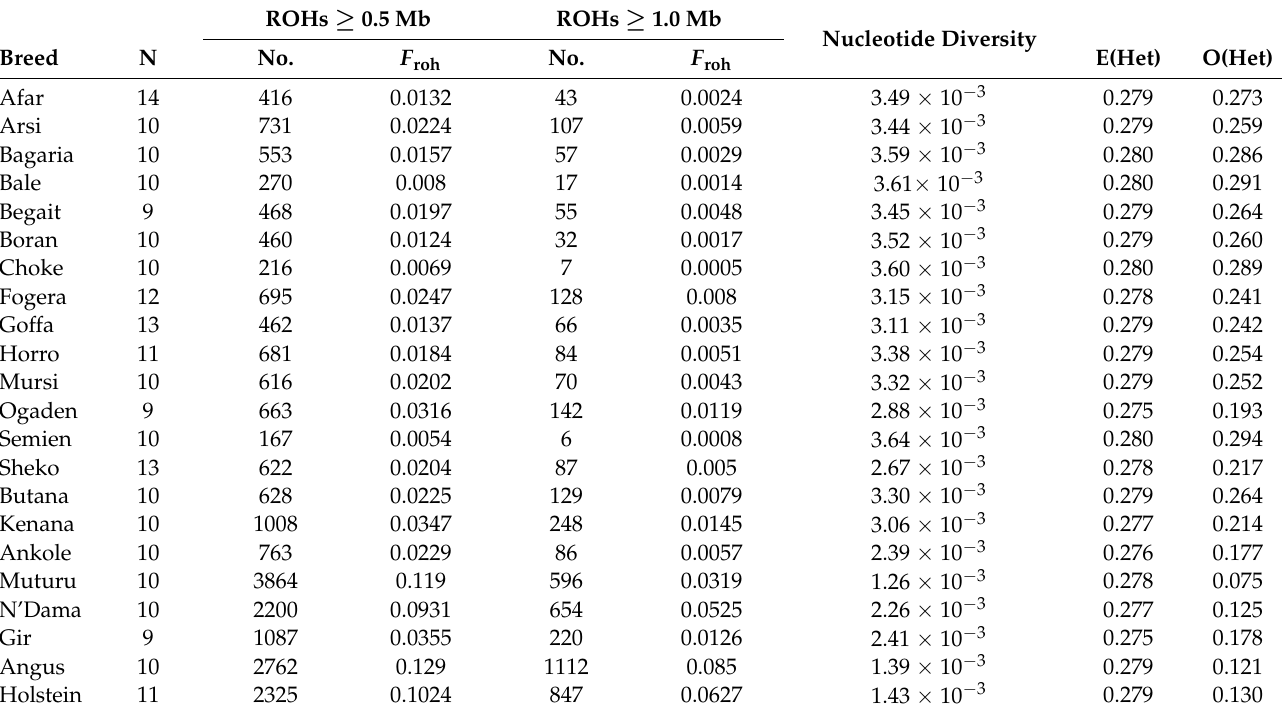
Table 2. Length and number of ROHs, genomic inbreeding coefficient ( F roh ), nucleotide diversity, observed and expected heterozygosity in Ethiopian and non-Ethiopian cattle populations. ROHs ≥ 0.5 Mb ROHs ≥ 1.0